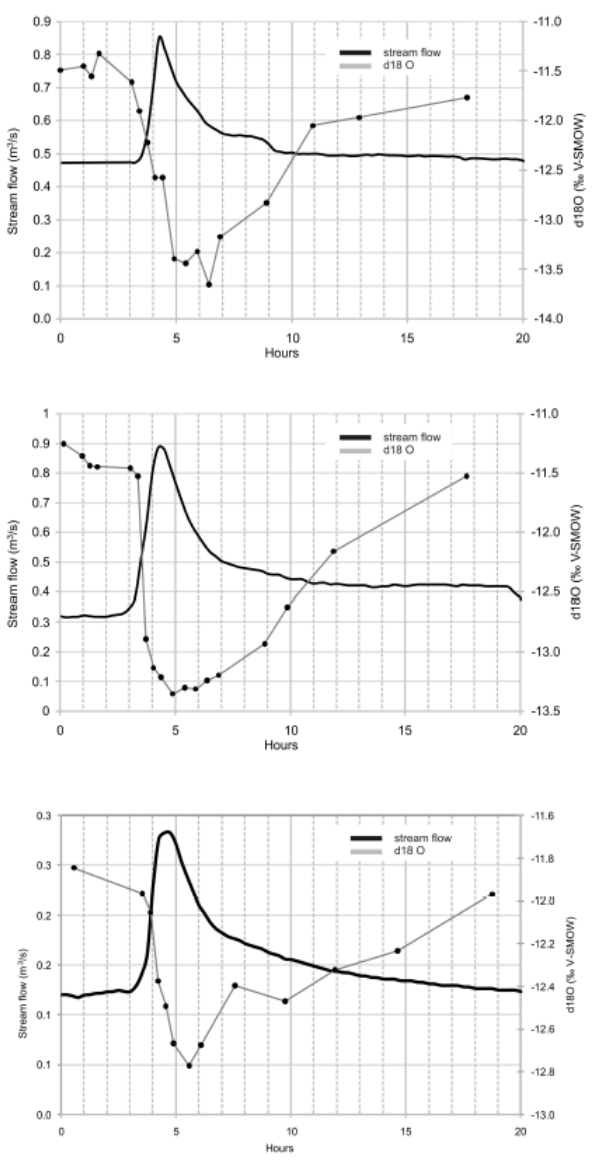
Fig. 2. Stream discharge and stream isotope signal for event 2 for B1 (top), B2 (center) and BB (bottom).